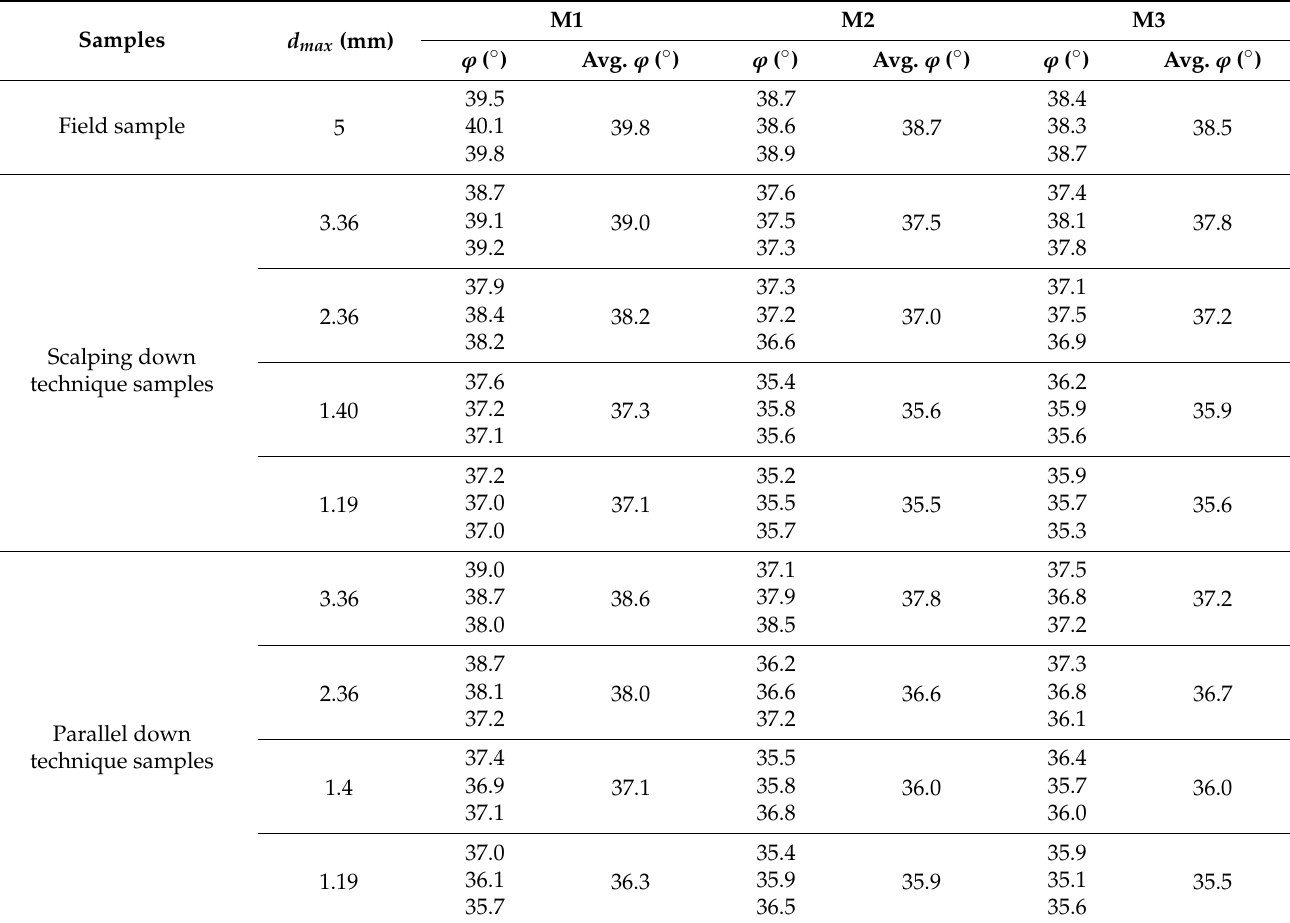
Table 5. Measured friction angles ( ϕ ) of the field and scaled down samples made of M1, M2 and M3.